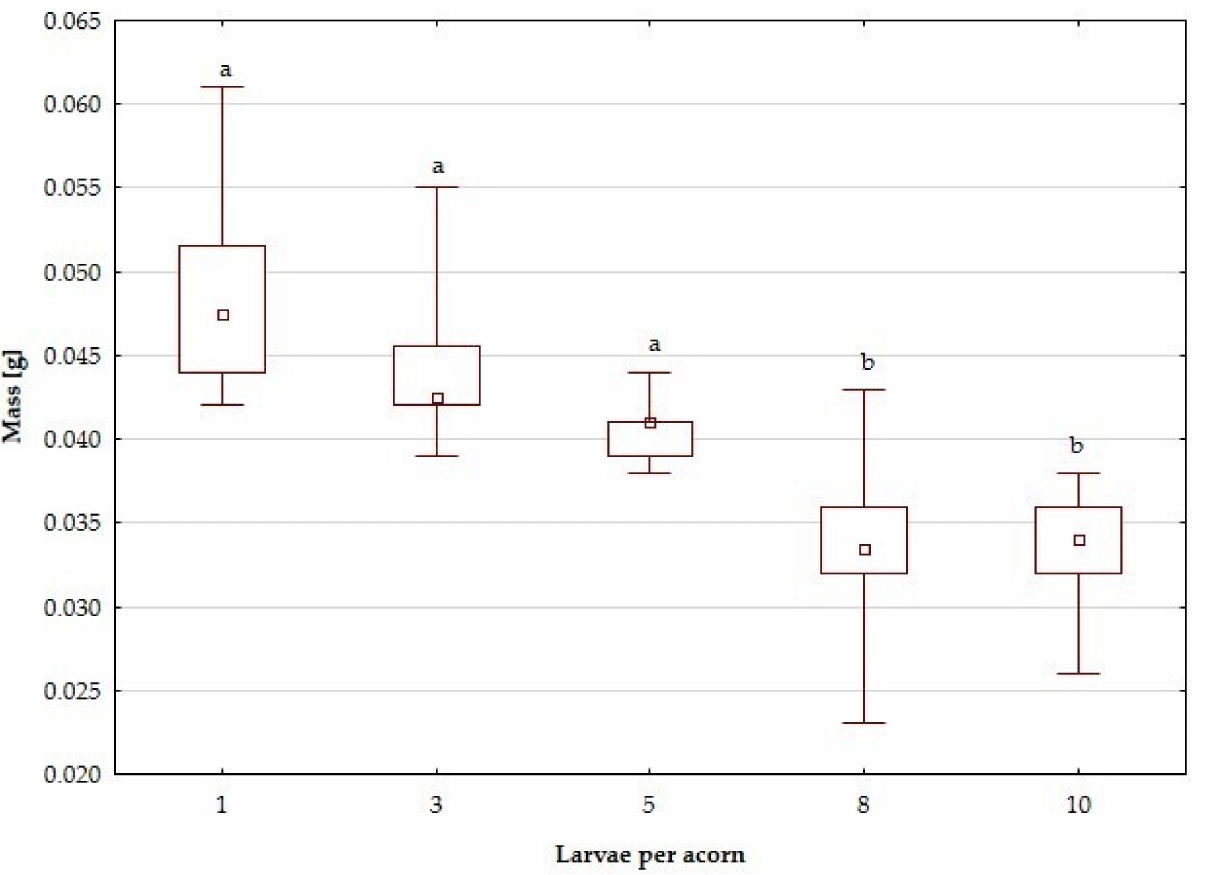
Figure 3. Distribution of larval masses in acorns inhabited by one, three, five, eight and ten larvae, respectively. Markings: squares—medians, box—quartile range (25–75%), whiskers—min/max values; different lowercase letters indicate significant differences (Dunn’s post-hoc, p <